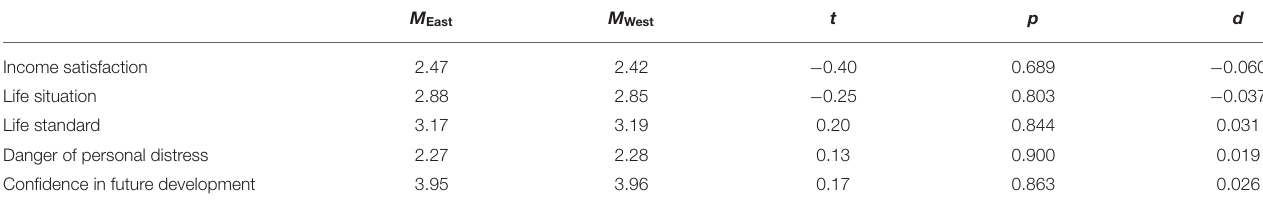
TABLE 2 | Comparison of living conditions and life satisfactions at baseline (1994). M East M West